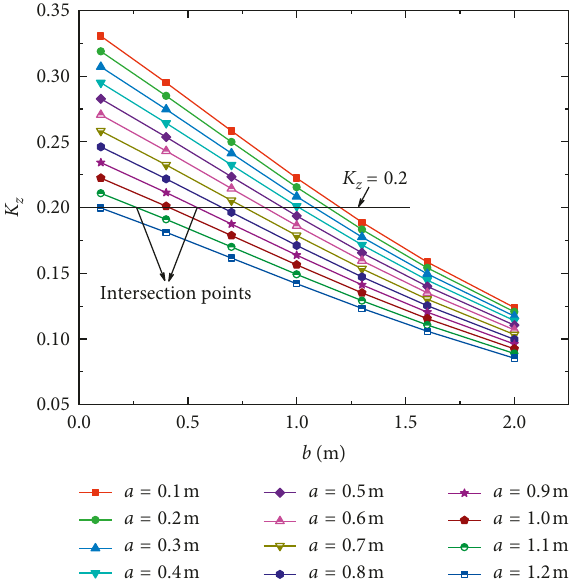
Figure 24: Relationship between K